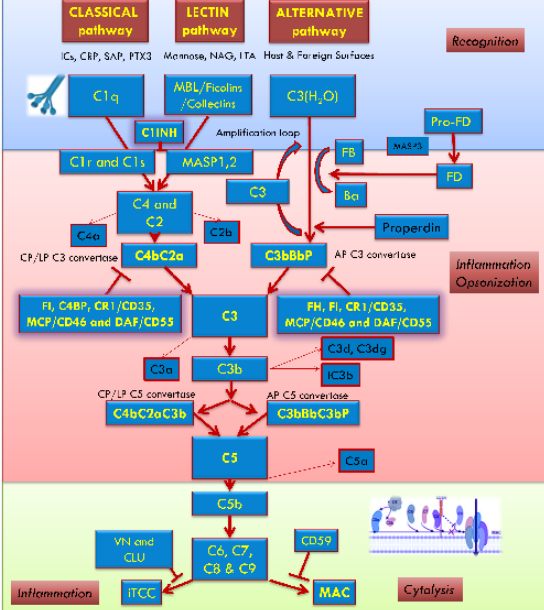
Figure 1. The C activation occurs through three pathways: classical, alternative, and lectin. The recognition and activation phases in each pathway converge on the formation of C3 convertase. The amplification phase starts when the C3 convertase cleaves C3, and C3b attachment to C3 convertases changes their substrate specificity, allowing them to become C5 convertase. The C5 convertase cleaves C5, starting the last phase (Terminal-Attack phase), in which C5b forms the membrane attack complex (MAC) with C6, C7, C8, and C9, resulting in cell perturbation. AP: alternative pathway; C1INH: C1-inhibitor; C4BP: C4b-binding protein; CLU: clusterin; CP: classical pathway; CR1: C receptor 1; DAF: decay-accelerating factor; FB: factor B; FD: factor D; FH: factor H; FI: factor I; ICs: immunocomplexes; iTCC: inactive terminal C complex; LP: lectin pathway; LTA: lipoteichoic acid; MCP: membrane cofactor protein; NAG: N -acetylglucosamine; Pro-FD: pro-factor D; SAP: serum amyloid P component; VN: